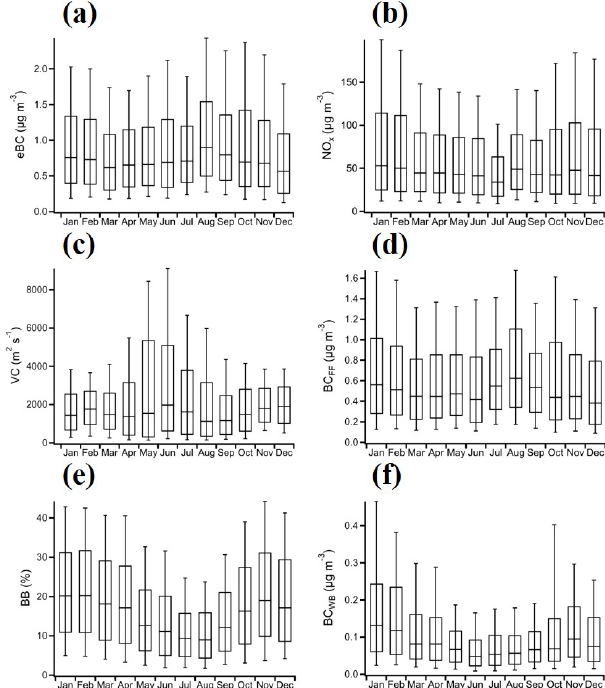
Figure 5. Monthly variation in eBC, NO x , VC, BC FF , BB, and BC WB . In each box, the mid-line shows the median value for each x value component, the whisker bottom and top correspond to the 10th and 90th percentiles, and the box top and bottom correspond to 75th and 25th percentiles,